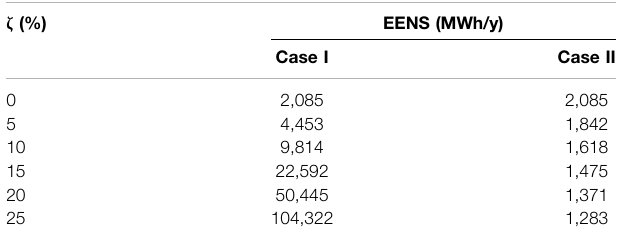
TABLE 3 | The impact ofrenewable energy penetration on EENS in cases 1 and 2